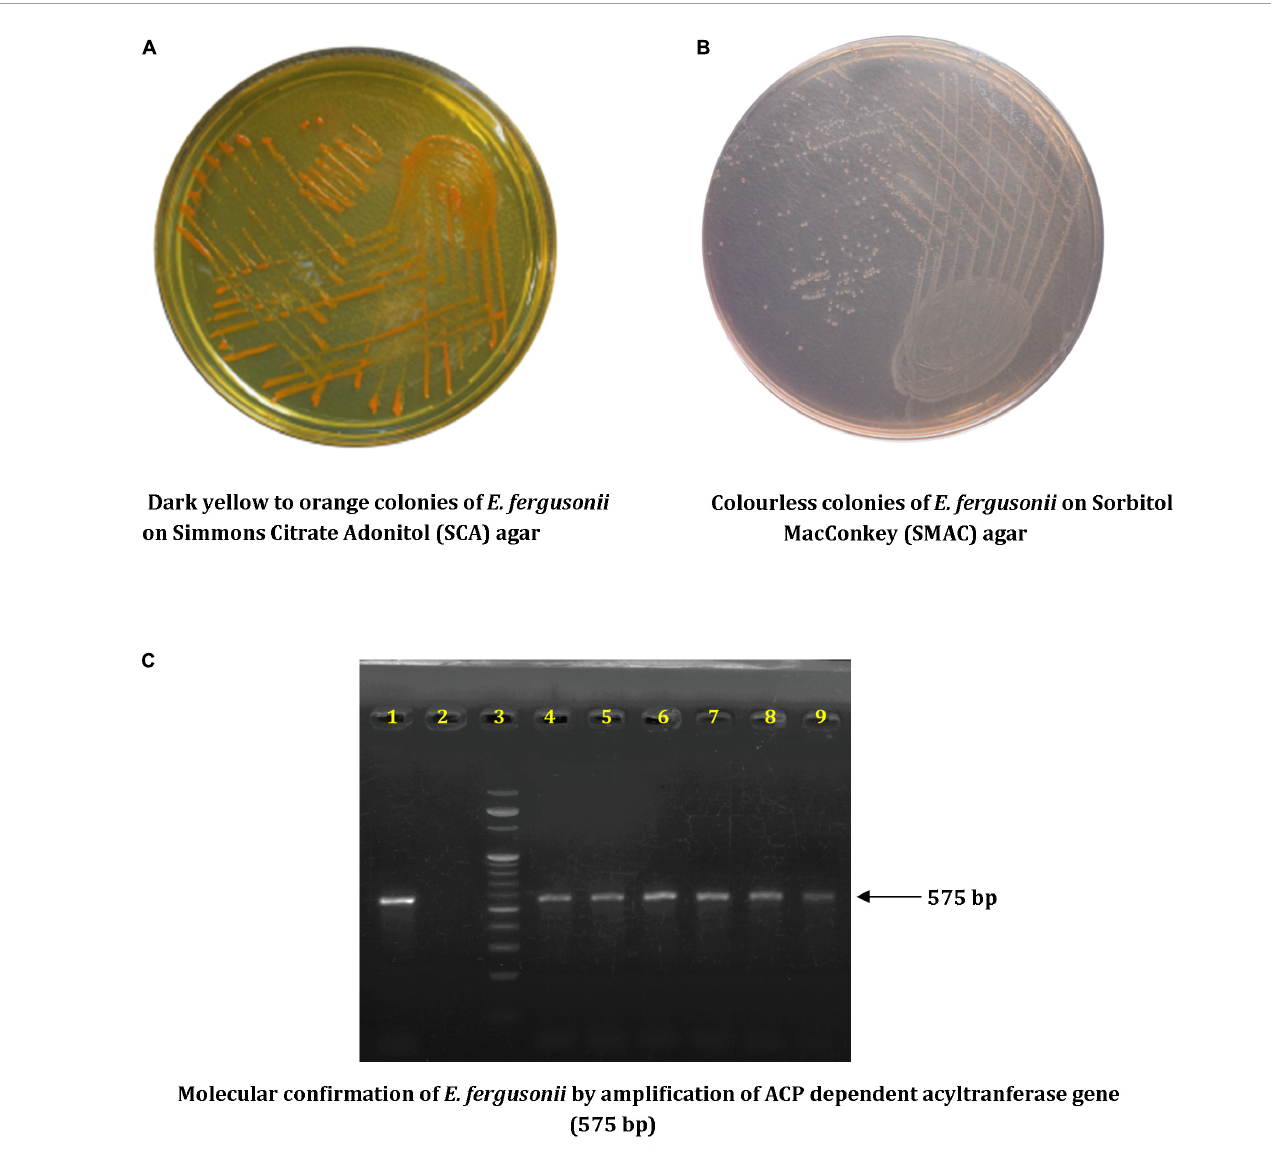
FIGURE1 Phenotypic and molecular characterization of Escherichia fergusonii isolates. (A) Dark yellow to orange colonies of E. fergusonii on Simmons Citrate Adonitol (SCA) agar. (B) Colorless colonies of E. fergusonii on Sorbitol MacConkey (SMAC) agar. (C) Molecular confirmation of E. fergusonii by amplification of ACP dependent acyltransferase gene (575